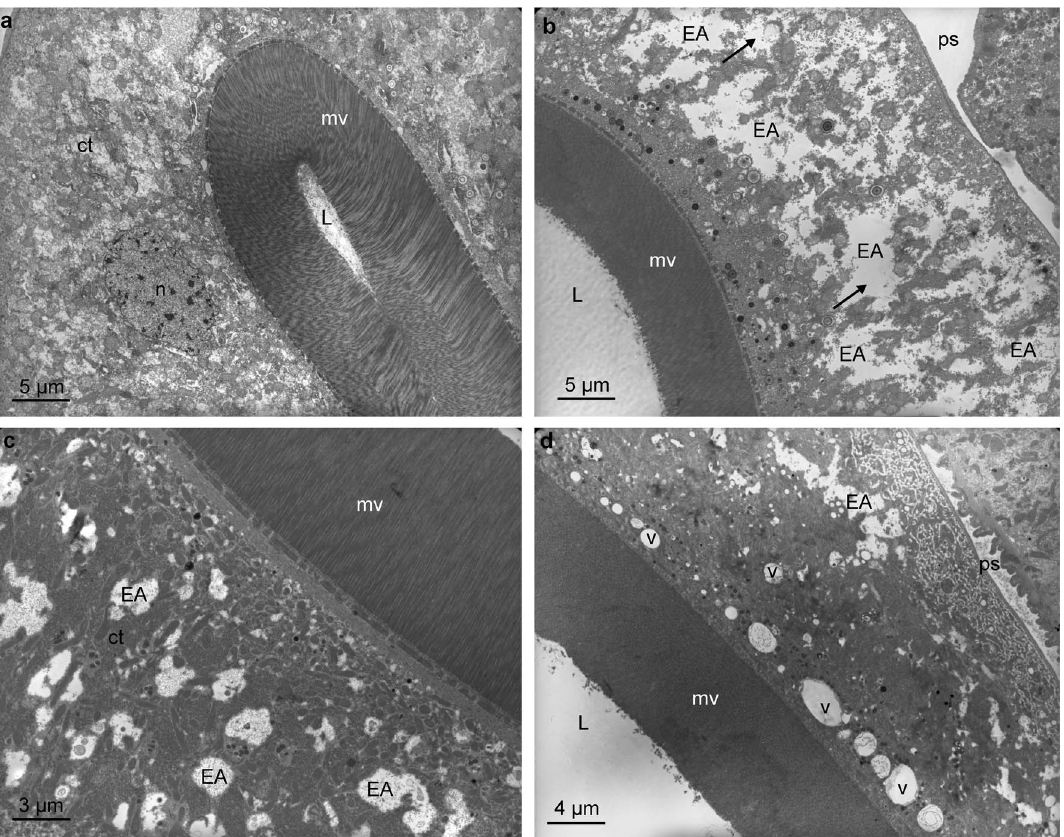
Figure 3. Transmission electron microscopy (TEM) of intestinal cells of Haemonchus contortus obtained from goats either (a) on control (polyphenol-free) diet, (b) fed tzalam fodder, (c) drenched with quebracho or (d) fed sainfoin fodder. The illustrations include nucleus (n), cytoplasm (ct), microvilli (mv), lumen (L), pseudocoele (ps) and the presence of vacuoles (v) and electrolucent areas (EA) indicated by arrows in Figure